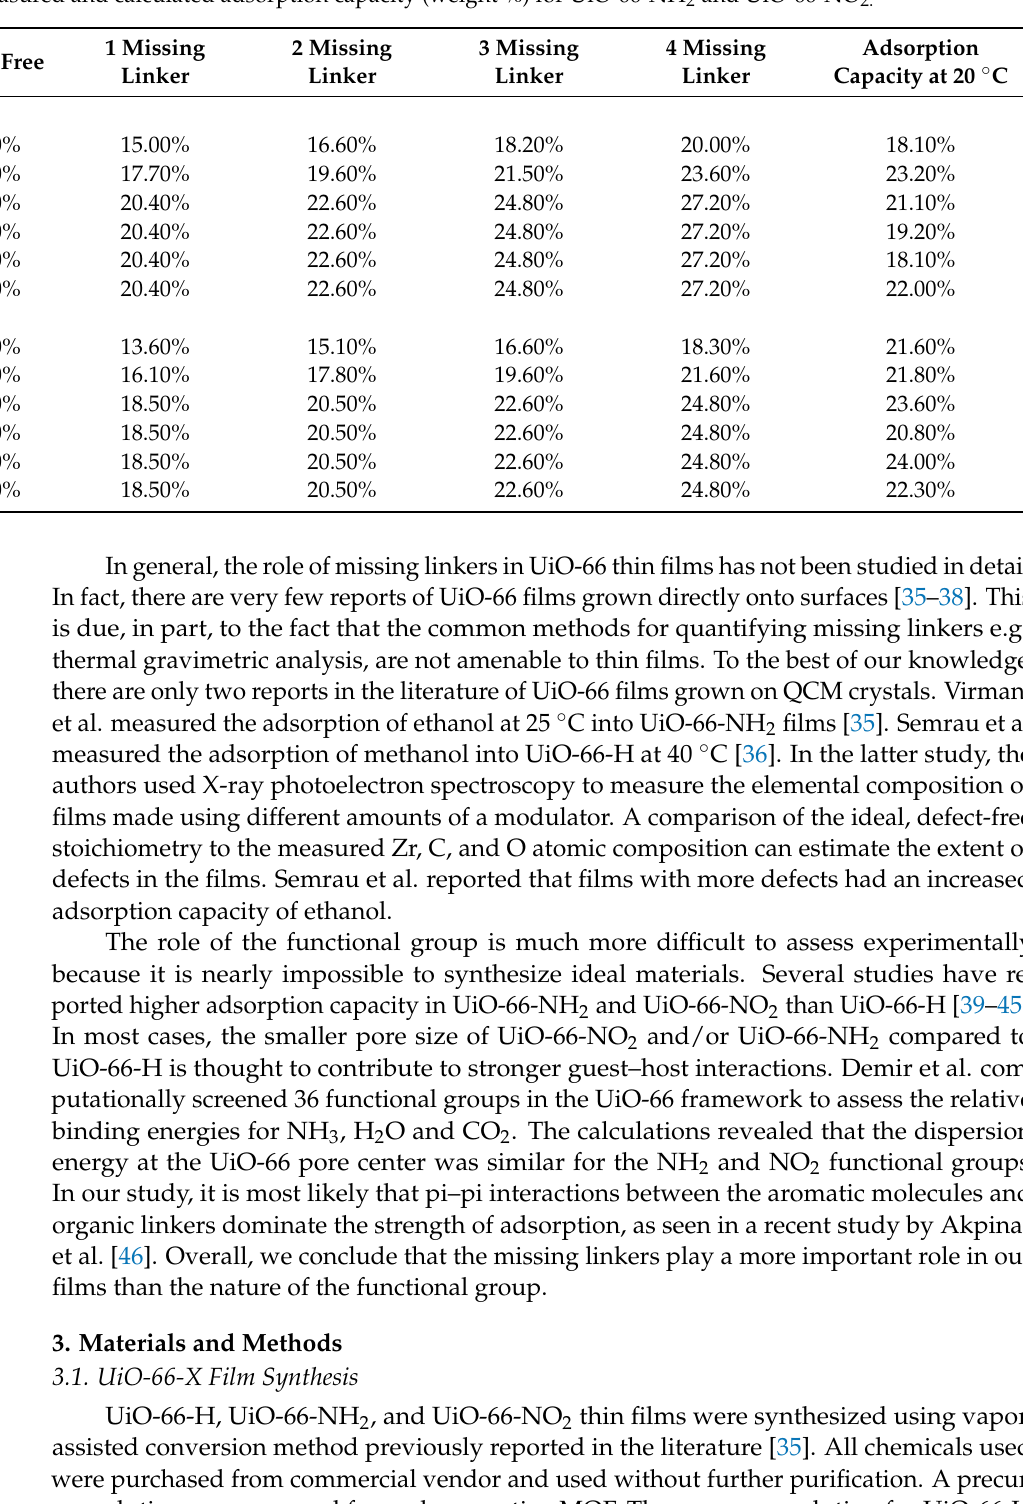
Table 1. Measured and calculated adsorption capacity (weight %) for UiO-66-NH 2 and UiO-66-NO